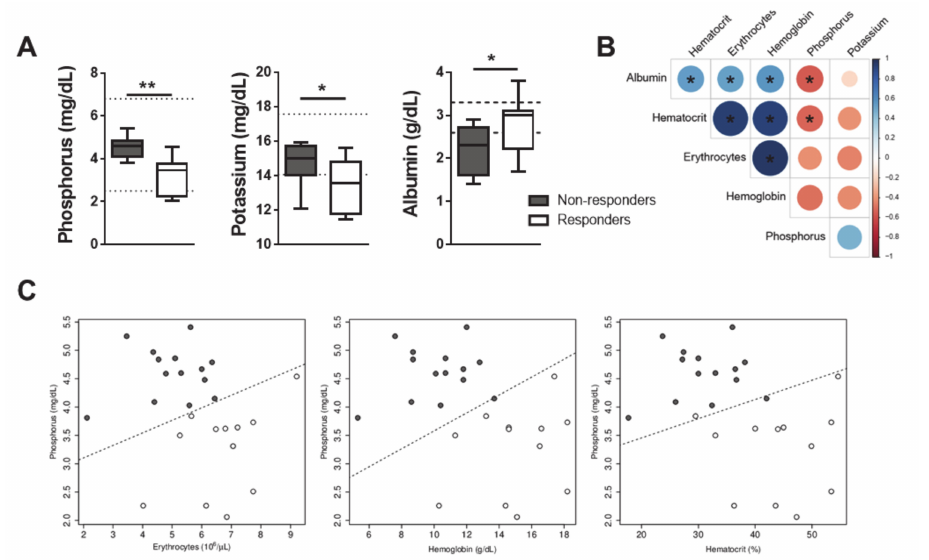
Figure 5. Development of a mathematical model with predictive value for the success of CanL chemotherapy including the measurement of the erythrocyte and phosphorus parameters. ( A ) The serum values of phosphorous, potassium and albumin were quantified at T0). ( B ) The Spearman linear correlation coe ffi cient is shown for serum albumin, hematocrit, erythrocytes, hemoglobin, phosphorous and potassium values. ( C ) Scatterplots between phosphorous and hematocrit or erythrocytes or hemoglobin serum values. Data are shown as mean ± SD or in a box and whisker plot format. Responder dogs ( n = 12), Non responder dogs ( n = 14). * p < 0.05; ** p <